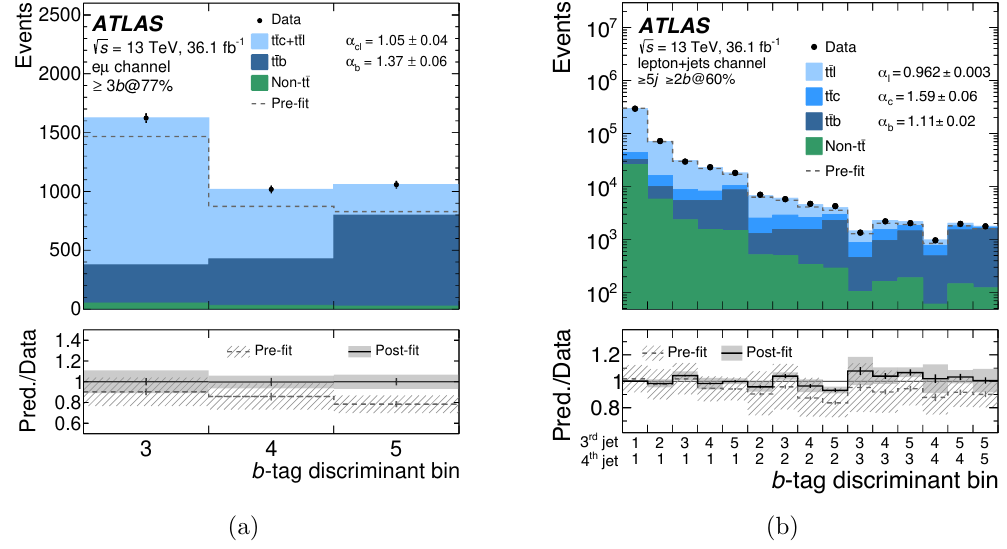
Figure 4. The b -tagging distribution of the third-highest b -tagging discriminant-ranked jet for the (a) e(cid:22) channel, and of the third and fourth b -tagging discriminant-ranked jet for the (b) lepton+jets channel. For clarity, the two-dimensional lepton + jets templates have been (cid:13)attened into one dimension. The ratios of total predictions before and after the (cid:12)t to the data are shown in the lower panel. The vertical bar in each ratio represents only the statistical uncertainty, and the grey bands represent the total error including systematic uncertainties from experimental sources. The extracted scale factors (cid:11) b ; (cid:11) c ; (cid:11) l ; (cid:11) cl are given considering only statistical